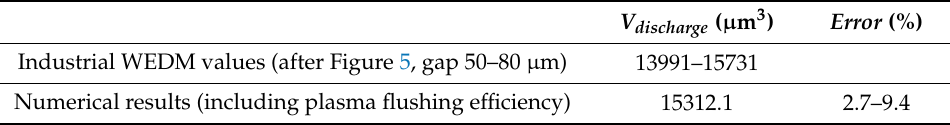
Table 6. Comparison between experimental and simulation